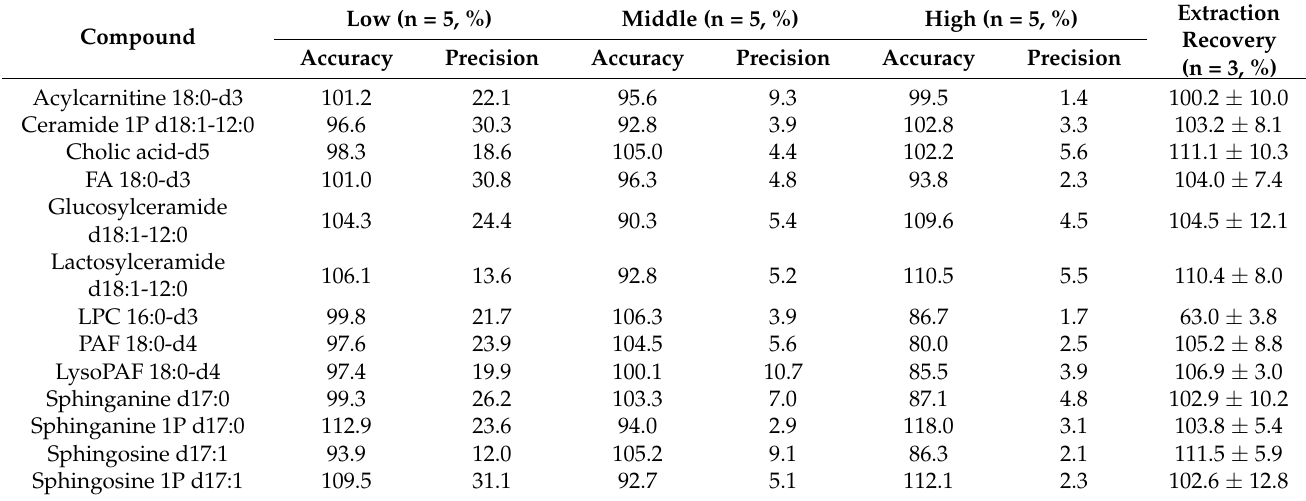
Table 2. Accuracy and precision of the IS in the LC–MS/MS